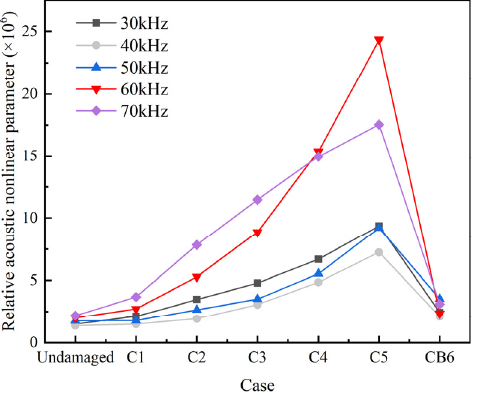
(cid:4593) at different cases